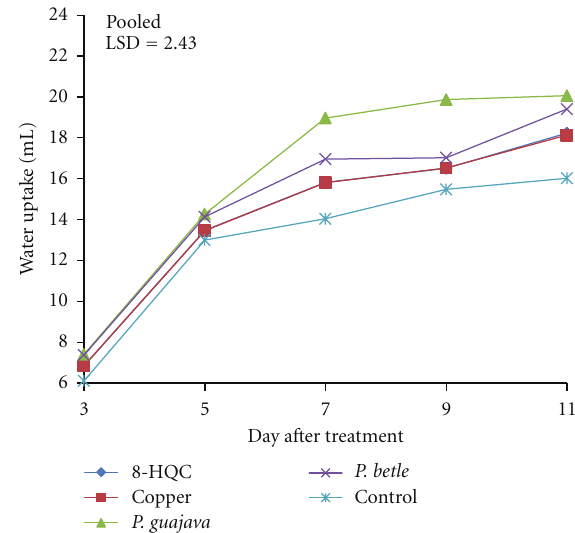
Figure 2: E ff ect of 8-HQC, copper coin, and leaf extracts of P. guajava and P. betle and control on water uptake of “Carola” cut carnation